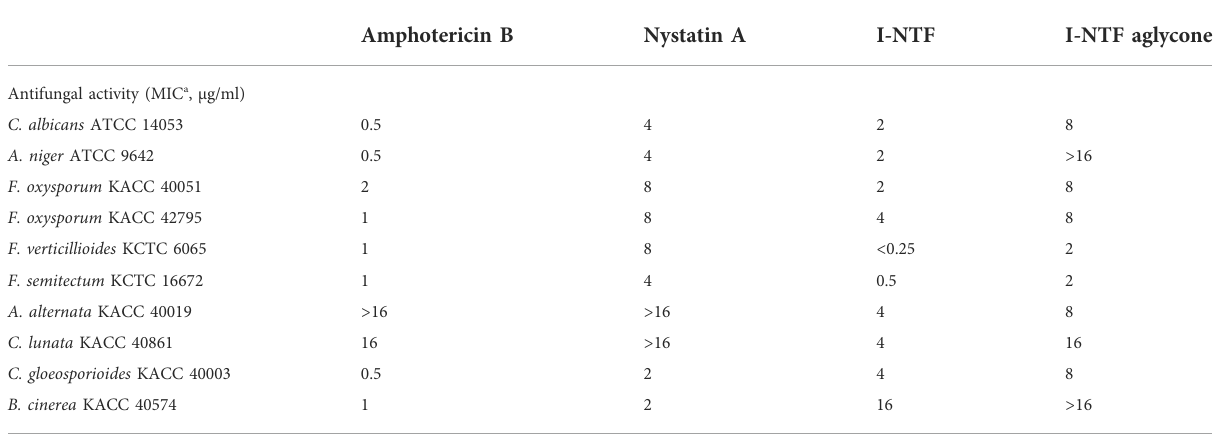
TABLE 1 In vitro antifungal activity of polyene. Amphotericin B Nystatin A I-NTF I-NTF